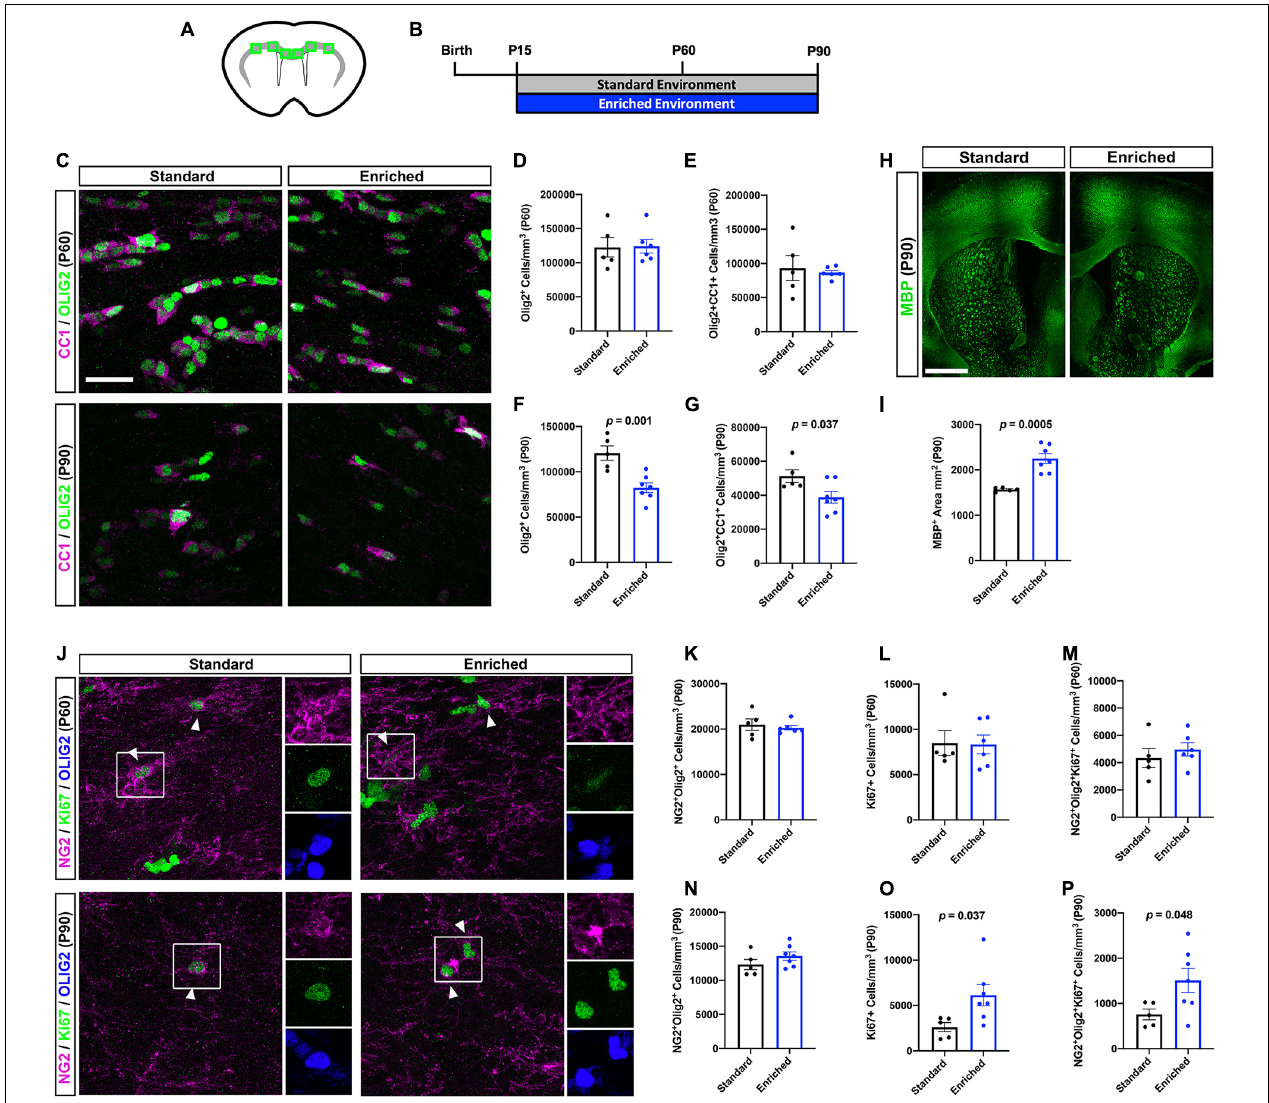
FIGURE 3 | Prolonged EE alters OL lineage cell dynamics in the subcortical WM. (A) Schematic depiction of the subcortical WM (gray) in a coronal slice, with green boxes representing the quantified regions (corpus callosum, cingulum, external capsule). (B) Experimental timeline. (C) Representative confocal images of CC1 (magenta) and OLIG2 (green)-expressing OLs in the subcortical WM at P60 (top) and P90 (bottom). (D,F) Quantification of OLIG + OL lineage cells in the subcortical WM of SD (black) and EE (blue) mice at P60 (D) and P90 (F) . (E,G) Quantification of OLIG2 + /CC1 + OLs at P60 (E) and P90 (G) . (H) Representative images of coronal slices immunohistochemically labeled with MBP (green) at P90. (I) Quantification of MBP + area in the subcortical WM at P90. (J) Representative confocal images of NG2 (magenta) and Ki67 (green)-expressing OPCs in the subcortical WM at P60 (top) and P90 (bottom). Arrowheads demarcate proliferating OPCs. (K,N) Quantification of NG2 + /OLIG2 + OPCs at P60 (K) and P90 (N) . (L,O) Quantification of Ki67 + proliferating cells at P60 (L) and P90 (O) . (M,P) Quantification of NG2 + /OLIG2 + /Ki67 + proliferating OPCs at P60 (M) and P90 (P) . Scale bar = 1mm for panel (H) and 25 µ m for all other